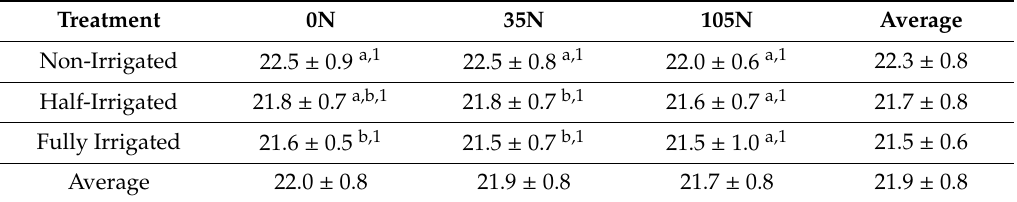
Table 18. The e ff ect of di ff erent fertilization rates on the seed oil concentration (%) of soybean (cv. Pannonia Kincse) under di ff erent irrigation regimes, averaged among 2017, 2018, and 2019 in Debrecen,